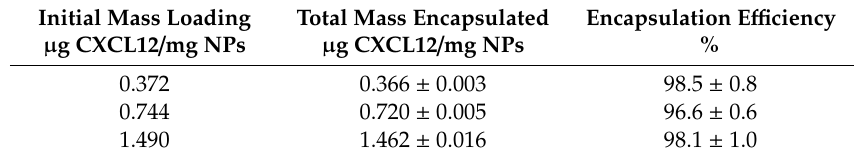
Table 1. Total mass encapsulated and encapsulation e ffi ciency of the CXCL12 in Alg / Chit NPs ( ±